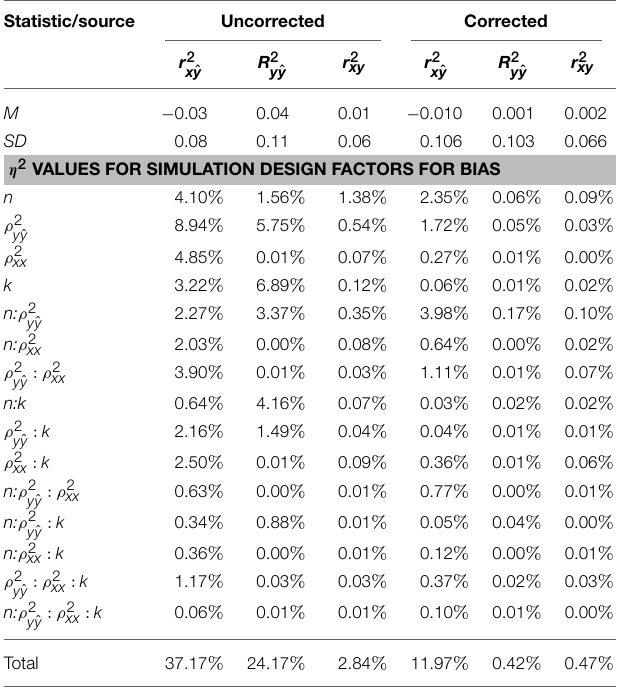
TABLE 2 | Statistics for bias within the 135 ( 3 × 3 × 3 × 5 ) simulation